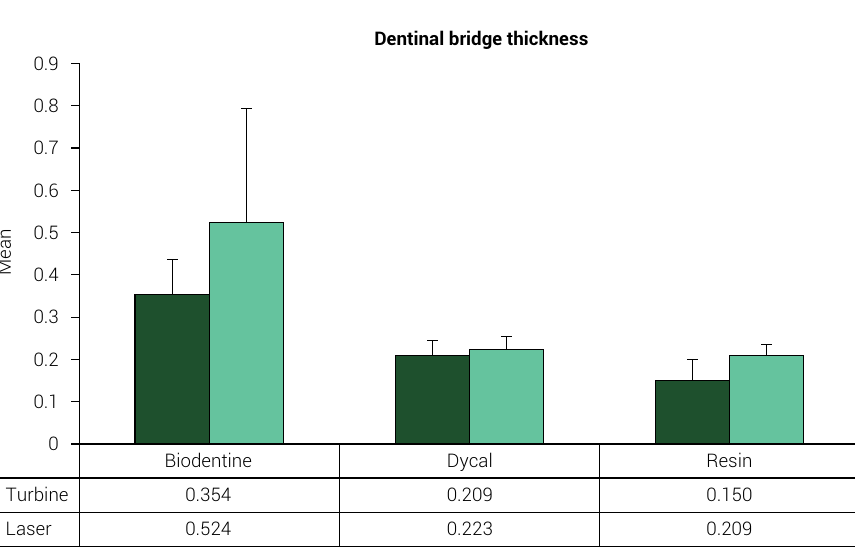
Figure 5. Dentinal bridge thickness among different groups